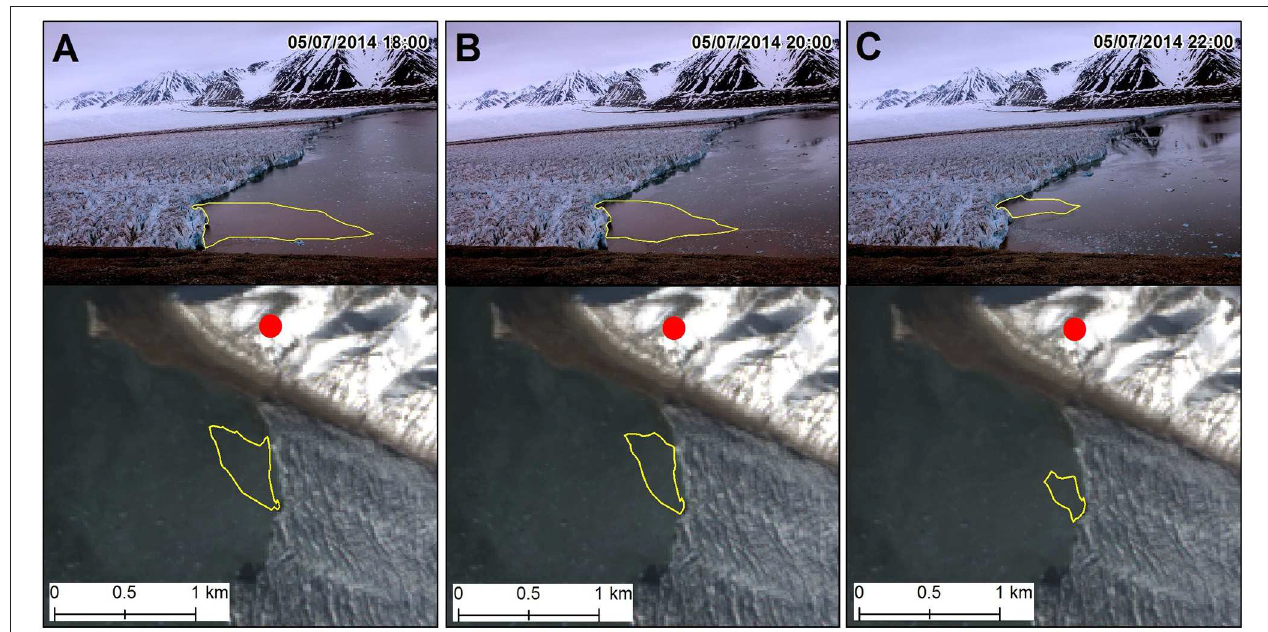
FIGURE 8 | Changes in meltwater plume extent distinguished from time-lapse imagery of Kronebreen camera KR1. The surface expression of the meltwater plume has been tracked through images captured on 05 July 2014 at 18:00 (A) , 20:00 (B) , and 22:00 (C) to demonstrate part of its diurnal recession. Each plot shows the plume definition in the image plane (top) and its translation to real-world coordinates and plotted onto a coinciding Landsat 8 satellite image (bottom). A similar example of this is provided with PyTrx at